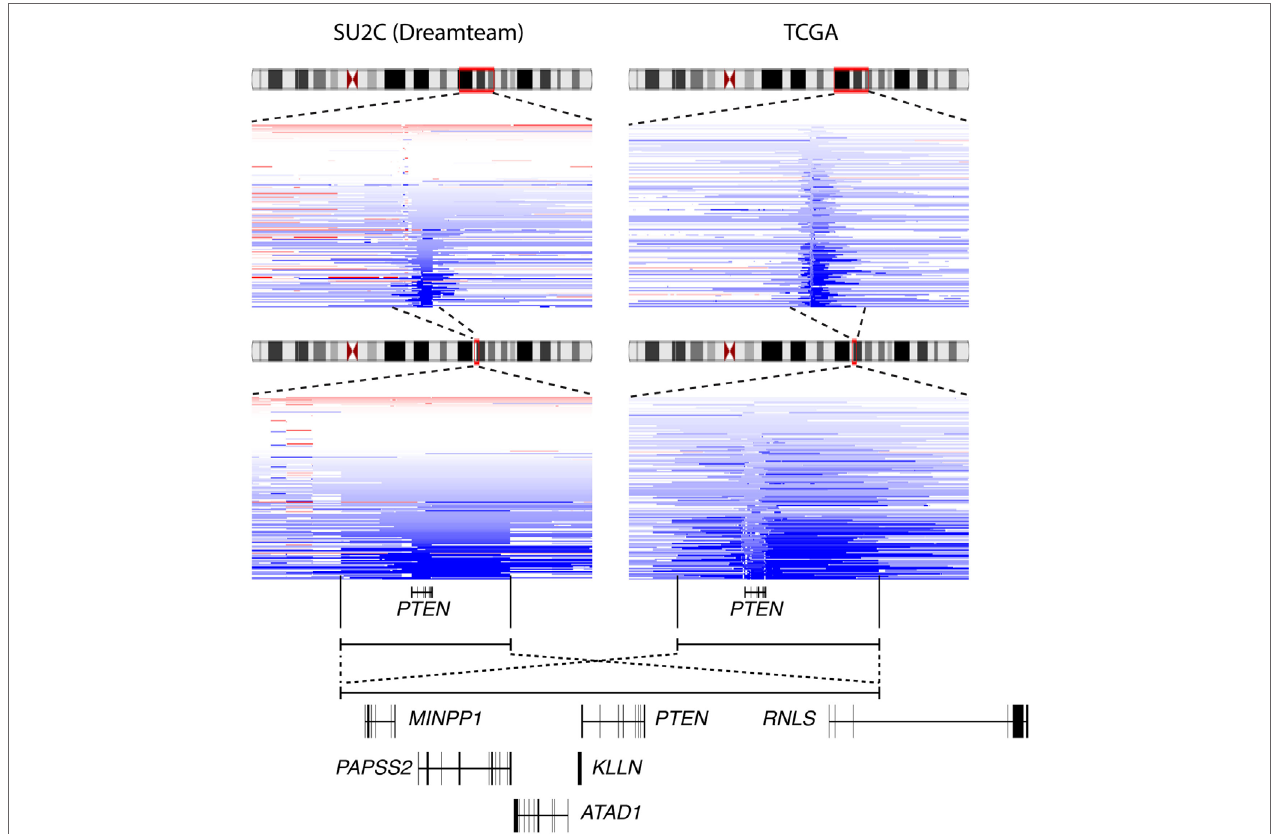
FiGUre 3 | The minimal deletion at 10q23 in prostate cancer (PCa). Deletion status at the 10q23 locus in the Stand Up To Cancer (SU2C) (left) and the The Cancer Genome Atlas (TCGA) (right) PCa clinical datasets. Blue color indicates copy number loss at this locus. Genes present in that genomic regions are shown (bottom